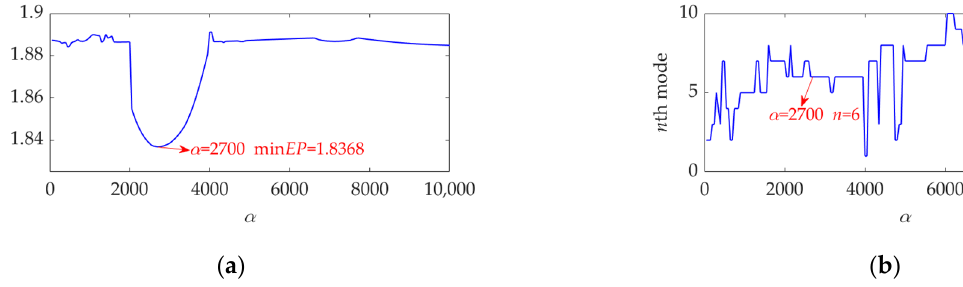
Figure 23. Relationship between the α value and ( a ) the EP index value and ( b ) order number of the target mode at each step of α increase.